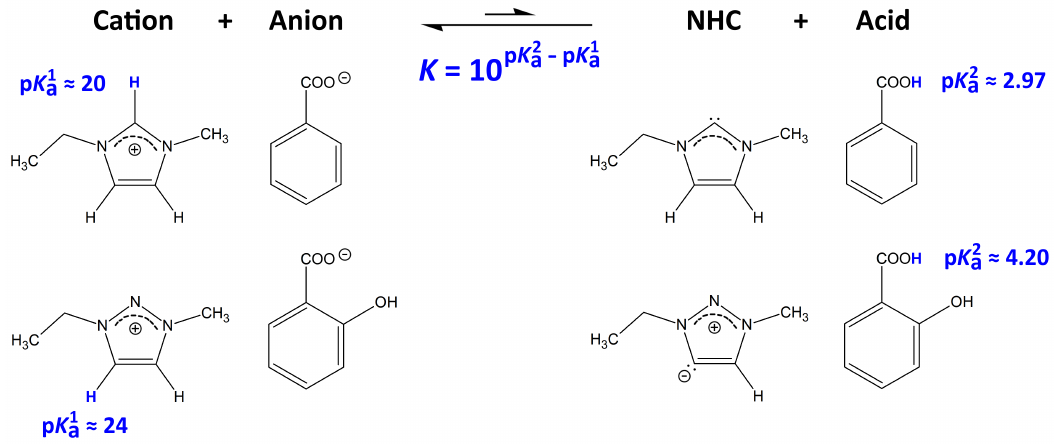
Figure 2. Process of N -heterocyclic carbene (NHC) formation for the ions involved in this study. The transferred protons are shown in blue color. p K a values are from the literature [44]. While p K 1 a describes the acidity of the cation, p K 2 a depicts the acidity of the acid corresponding to the anion after protonation. From the equation below the arrow, the equilibrium constant K of this process can be computed from the choice of anions and